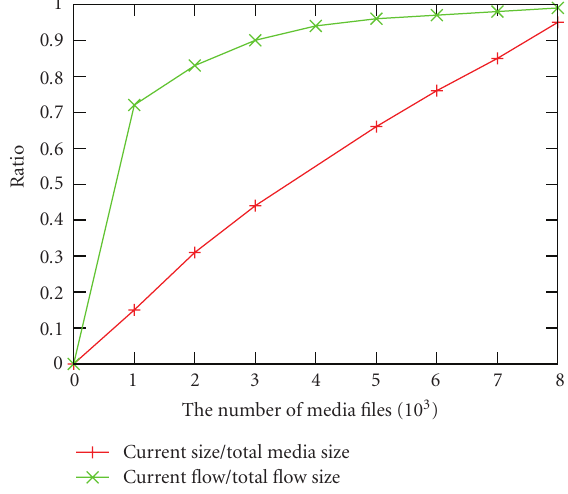
Figure 4: The relationship of file popularity.